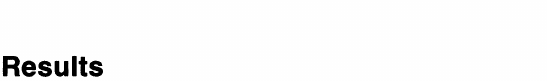
Fig. 1. Action of auto-IFN-o (1) and auto-IFN-7 (2) in vitro on human NK activity of PBL in healthy donors (A) and patients with MS (B). 107 PBL/ml in a volume of 0.4 ml were treated with auto-IFN-x or auto-IFN-7 for h at 37C followed by washing free of IFNs and co-incubation with K562 targets for 14 h at 37C in humid atmosphere containing 5% CO compared with TRP in healthy donors. The number of observations is displayed in parentheses. One observation corresponds to RP counted for one subject’s probe of